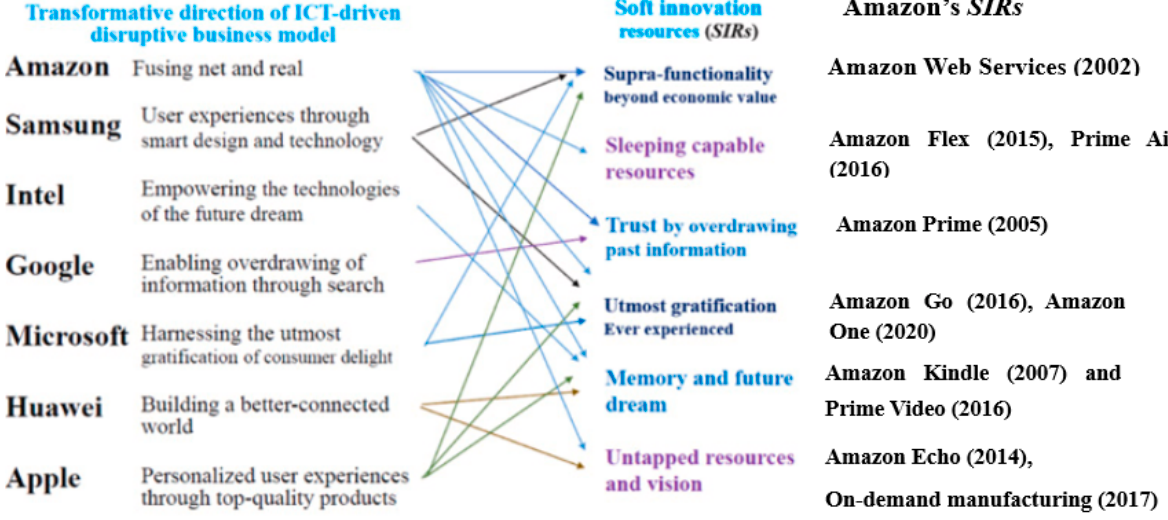
Figure 7. Soft innovation resources developed by top ICT leaders and corresponding examples in Amazon.